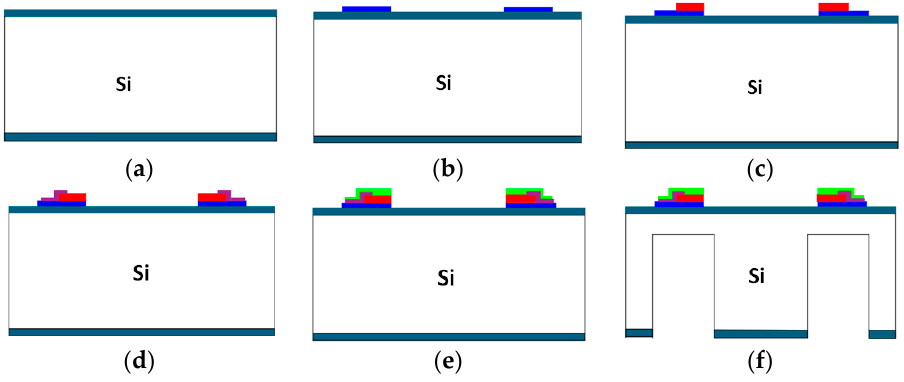
Figure 11. The process of fabrication. ( a ) Oxidated; ( b ) The lower electrodes; ( c ) PZT thin films and RTA; ( d ) Al 2 O 3 ; ( e )The upper electrodes; ( f ) ICP etching.